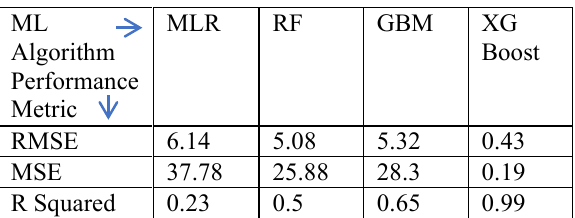
Table 2. Results for the month of April 2018 ML